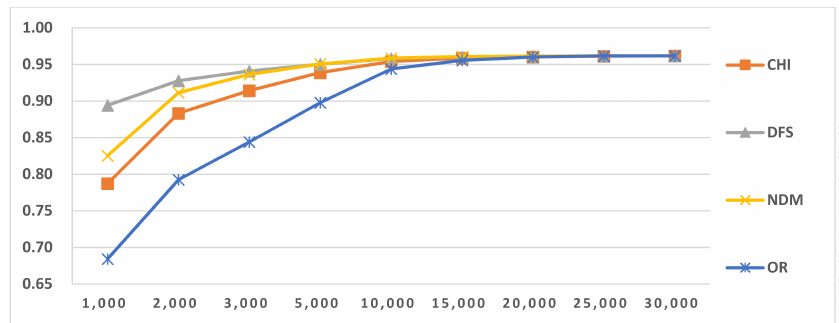
Figure 5. Results of LI in Latin script languages when selecting SVM and two-gram.